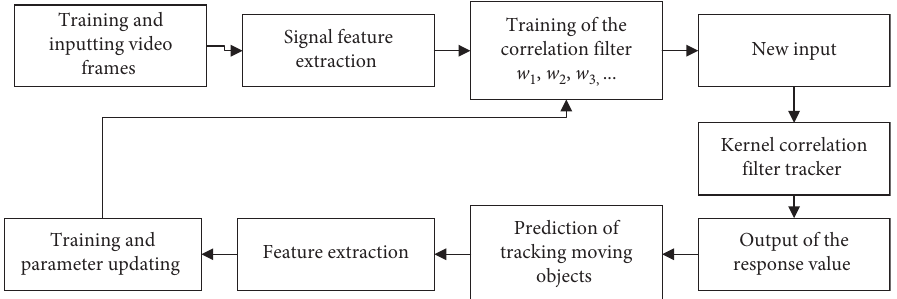
Figure 1: Implementation process of the modified kernel-related filter tracking